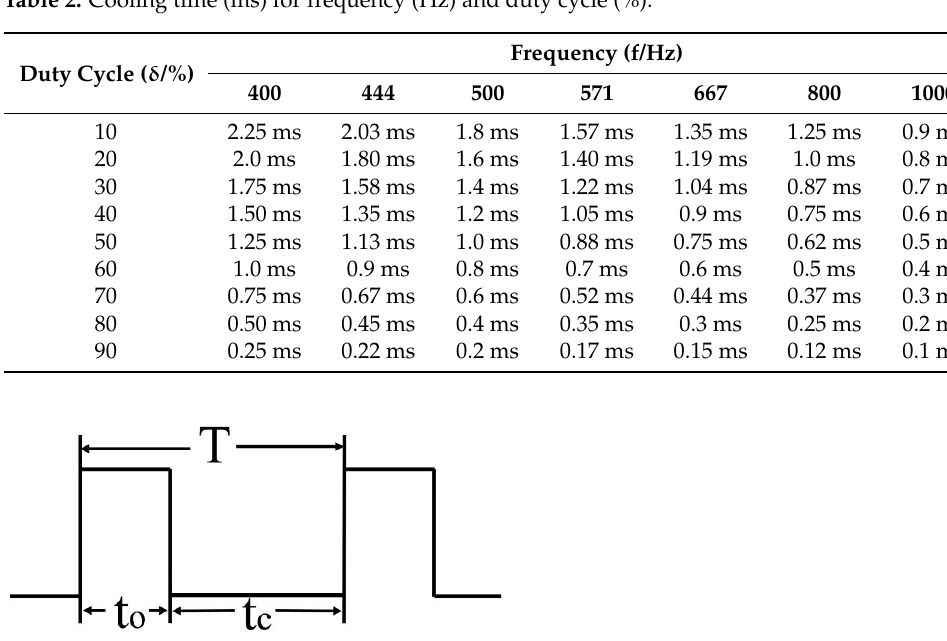
Figure 1. Schematic diagram of voltage output waveform, operating time (t o ) and cooling time (t c ) under one period (T).